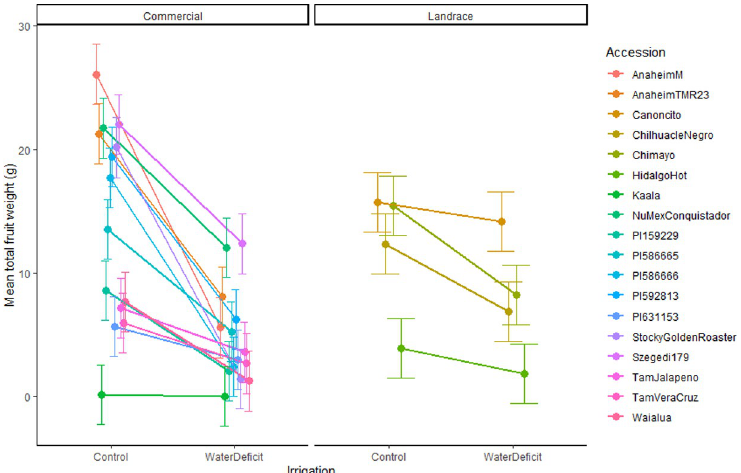
Fig 3. Interaction plot of estimated marginal means with standard error bars for mean fruit weight in U.S. accessions only in a greenhouse soil water deficit experiment on chile pepper ( Capsicum sp.) at the Ohio State University. Accessions are separated by domestication level.